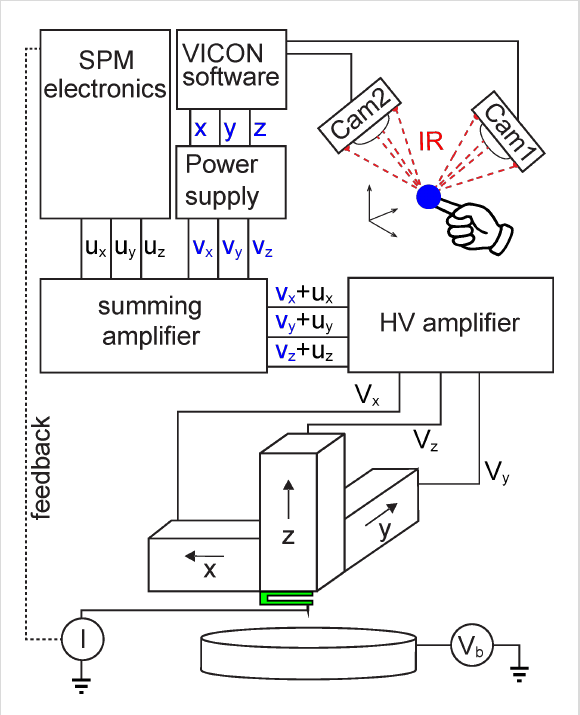
Figure 2: Scheme of the set-up for manual control of the SPM tip. Lamps mounted on the front of the two cameras emit infrared light that is reflected by a single marker fixed rigidly to the hand of the operator. The reflected light is captured by the cameras; with two cameras full three-dimensional triangulation is achieved. At the system output the real-time x ( t ), y ( t ), z ( t )-coordinates of the marker are extracted. These coordinates are converted into a set of three voltages v x , v y , v z that are further added to the u x , u y , u z voltages of the SPM software used to control the scanning piezo-elements of the microscope. In this way when the feedback loop is closed the position of the SPM tip is controlled by the SPM software, but when the feedback loop is open the tip is controlled by the hand of the operator. During the manipula- tion v x + u x , v y + u y and v z + u z voltages are sampled at a frequency of 1